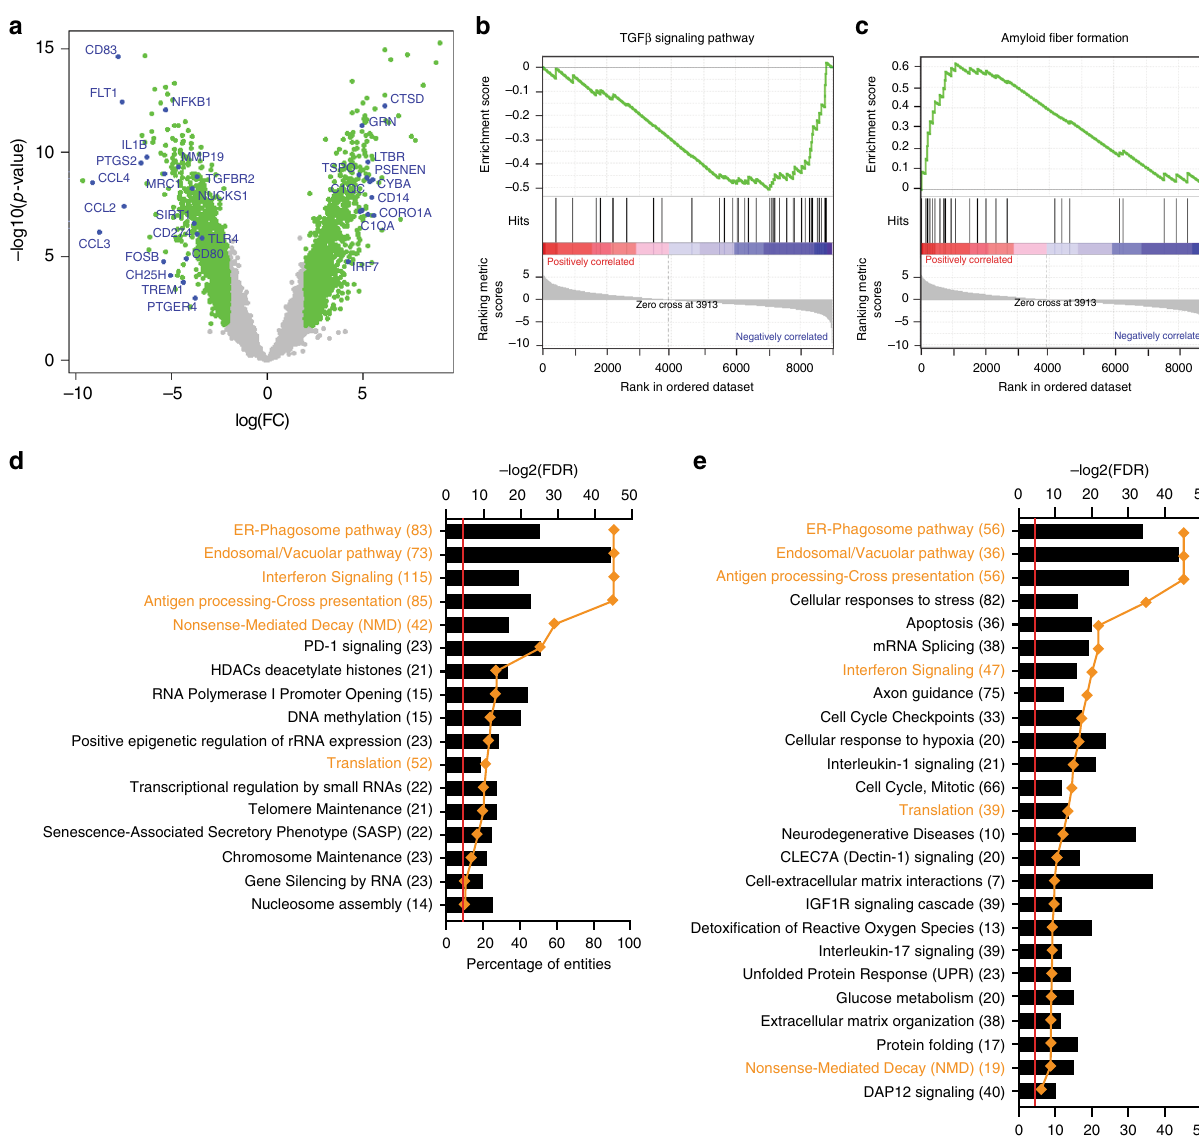
structured, quantitative neuropathologic examination at autopsy. All brain autopsies, experiments, and data analysis were done in compliance with protocols approved by the Partners Human Research Committee and the Rush University Institutional Review Board. The data presented in this study originates from ten donors. The clinicopathological characteristics of the participants are shown in Supplementary Table 1. Their mean age at death was 95 years and 80% of them were female. Nine out of ten of the participants showed a range of amyloid and tau pathology accumulation that is typical in this type of older, population-based sample. Three of the donors were ante mortem diagnosed with clinical AD.